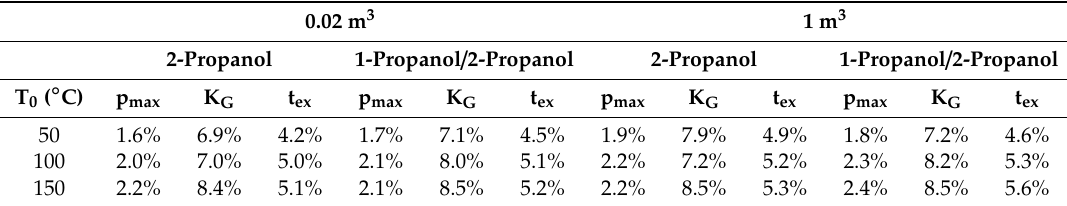
Table 3. Maximum measurement uncertainty.